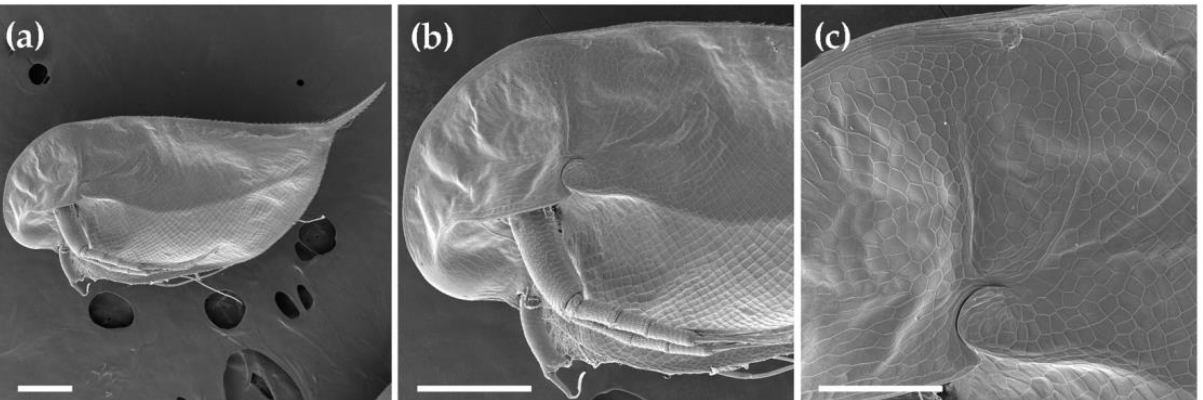
Figure 6. Daphnia arabica , an adult male from Al Shuwaib Dam, near Al Ain city, United Arab Emirates. ( a ) Male, lateral view;. ( b ) head; ( c ) head with higher magnification. Scale bars: 0.2 mm for ( a , b ), 0.1 mm for ( c ).